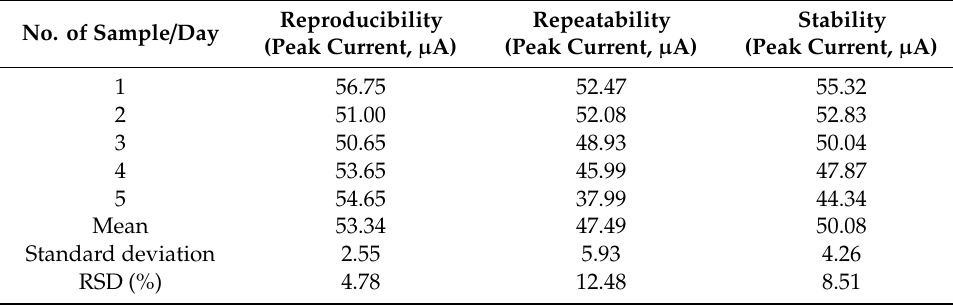
Table 2. Reproducibility, repeatibility, and stability study of the SiNPs / SPCE